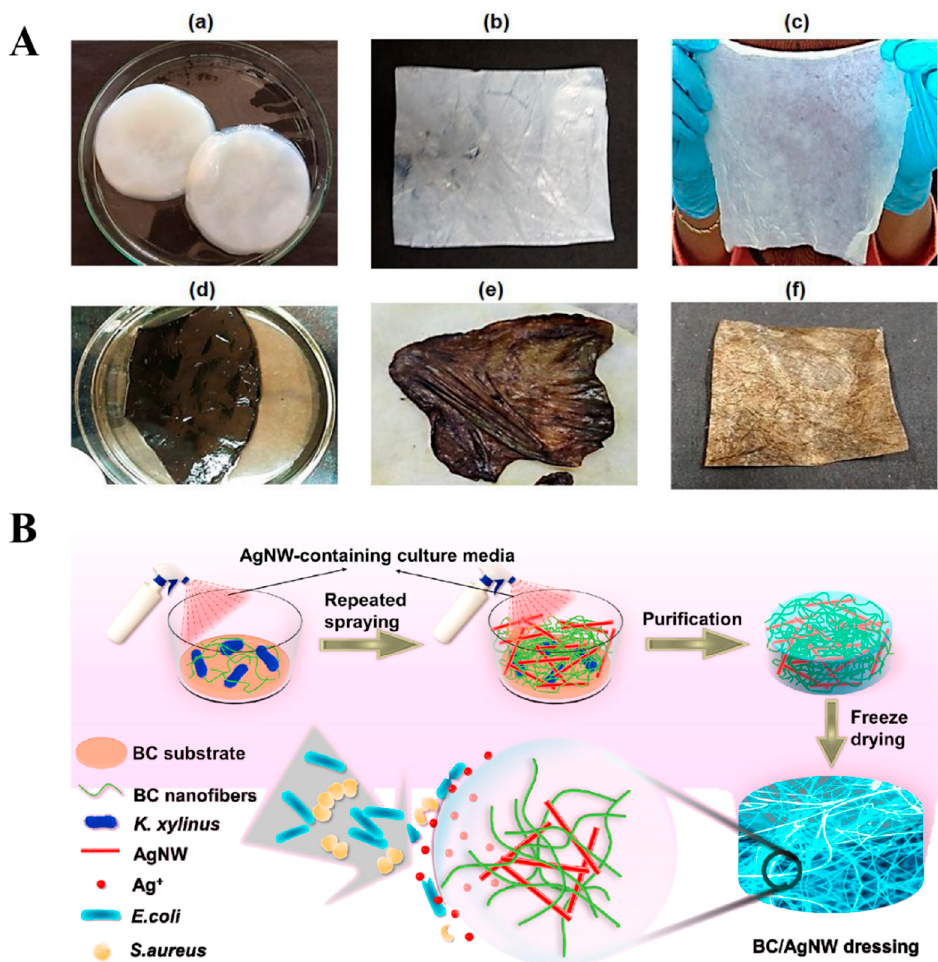
Figure 1. ( A ) Digital photograph images of (a) freshly prepared BC scaffold, (b) dried BC, (c) swollen